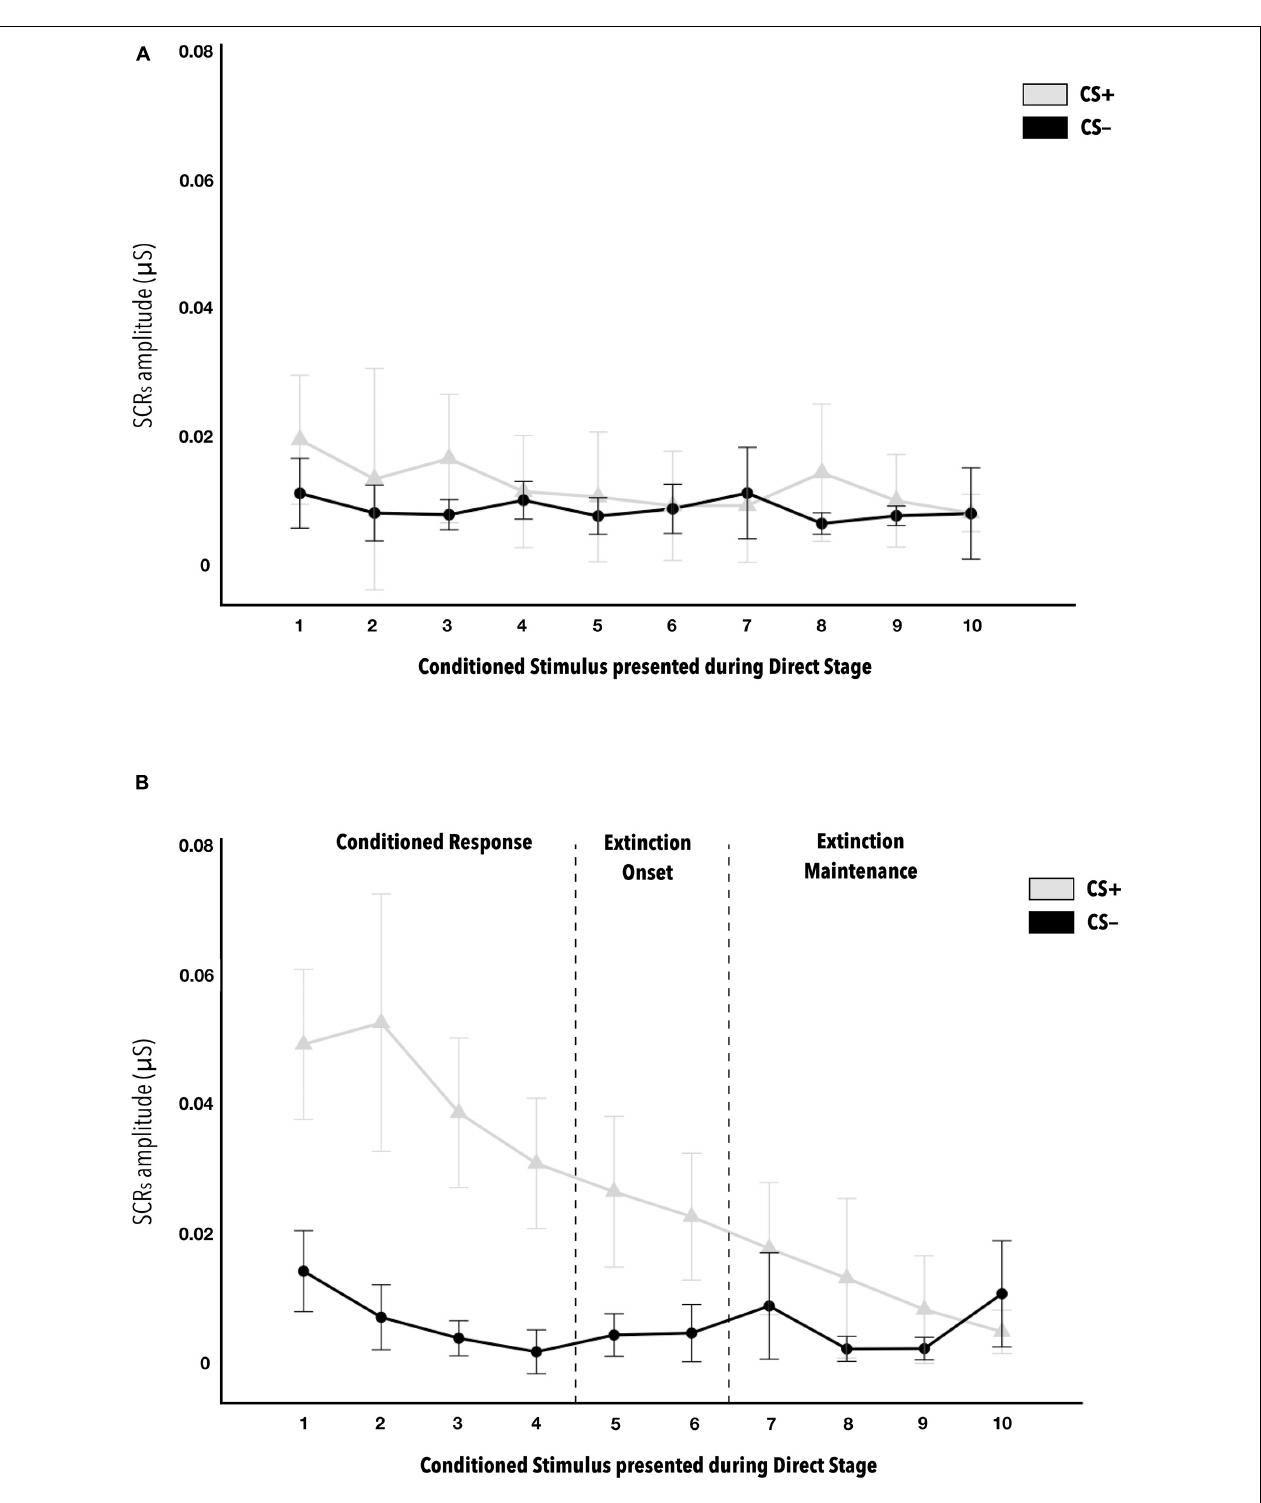
FIGURE 3 | Mean amplitudes of skin conductance responses to CS − and CS+ stimuli during the direct phase of the fear conditioning paradigm, according to level of contingency learning. Figure (A) is for the COND-Low group, that is, those that did not show correct vicarious conditioning, while Figure (B) is for the COND-H group. In Figure (B) of the COND-High group, statistically significant differences are indicated between the first six CS+ versus CS − ( d = 0.563). Beginning with seventh CS+ presentation, no differences were observed with respect to CS − . This indicates when habituation is produced. Statistically significant differences were also observed between CS + 1 versus CS + 5 ( d = 0.646), indicating the start of this habituation. The error bars show standard error. The post hoc analyses have p <